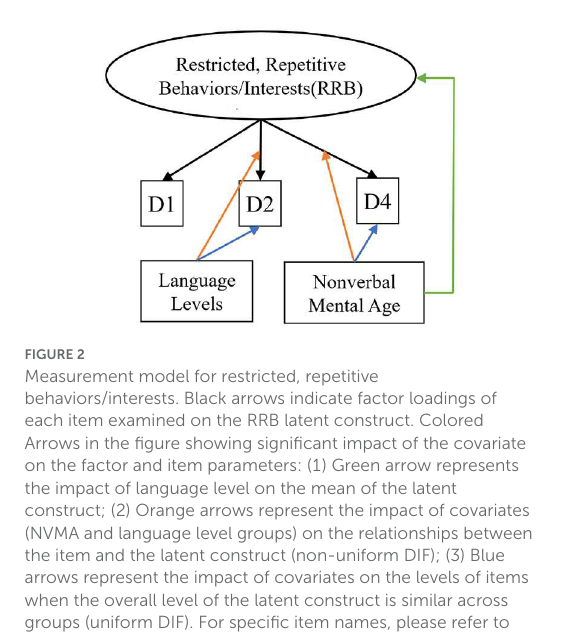
FIGURE2 Measurement model for restricted, repetitive behaviors/interests. Black arrows indicate factor loadings of each item examined on the RRB latent construct. Colored Arrows in the figure showing significant impact of the covariate on the factor and item parameters: (1) Green arrow represents the impact of language level on the mean of the latent construct; (2) Orange arrows represent the impact of covariates (NVMA and language level groups) on the relationships between the item and the latent construct (non-uniform DIF); (3) Blue arrows represent the impact of covariates on the levels of items when the overall level of the latent construct is similar across groups (uniform DIF). For specific item names, please refer to Table